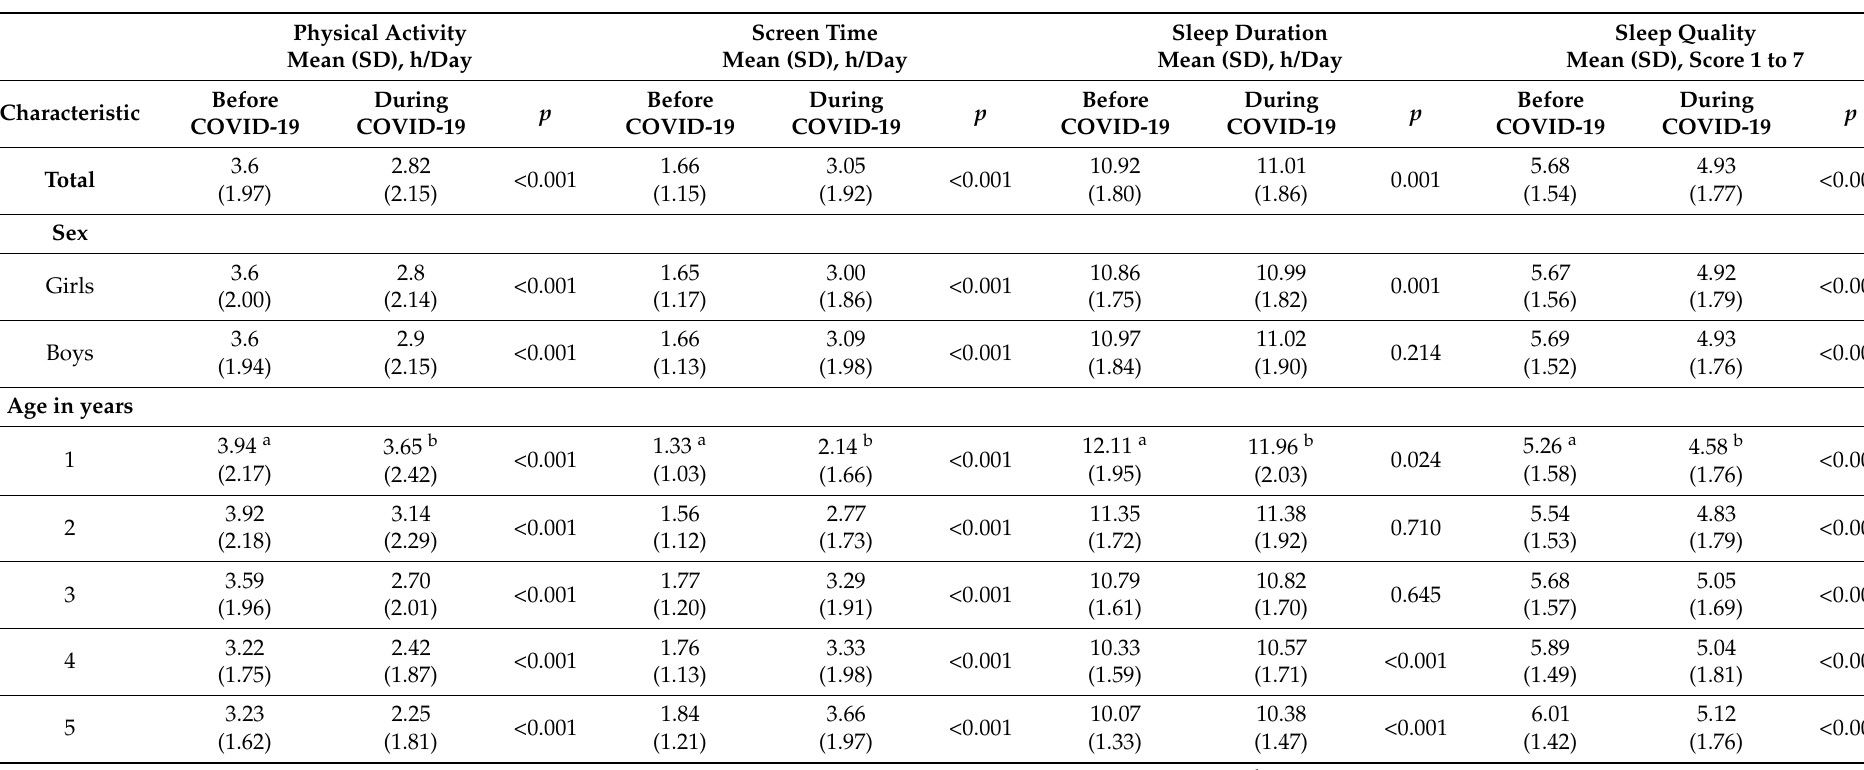
Sleep Quality Mean (SD), Score 1 to 7